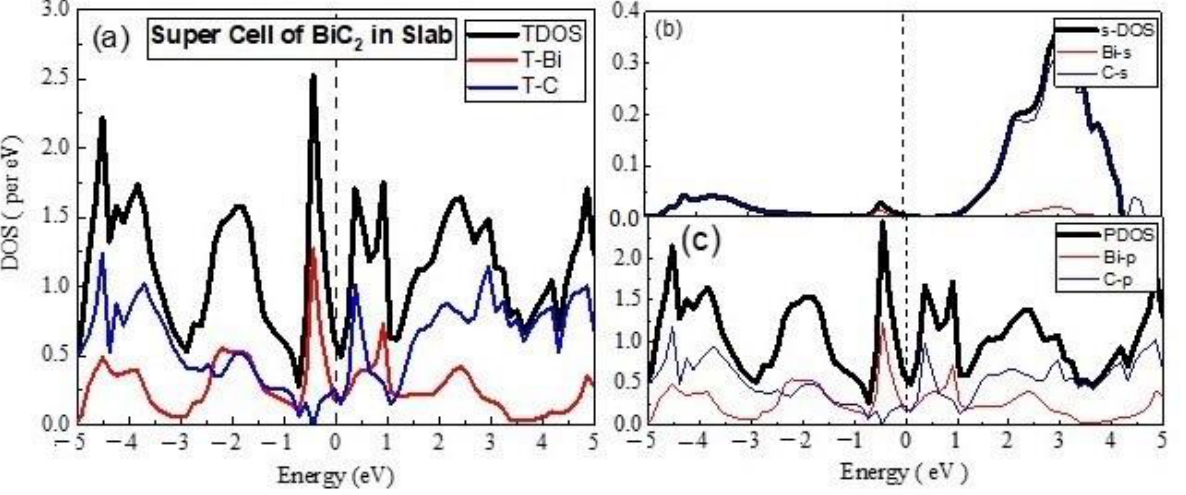
Figure 5. The calculated total density of states (TDOS) and partial density of states for BiC 2 Super cell ( a ) TDOS of slab ( b ) s-DOS of slab ( c ) p-DOS of slab. The Fermi level was adjusted at 0 eV. (C) Unit Cell of BiC 3